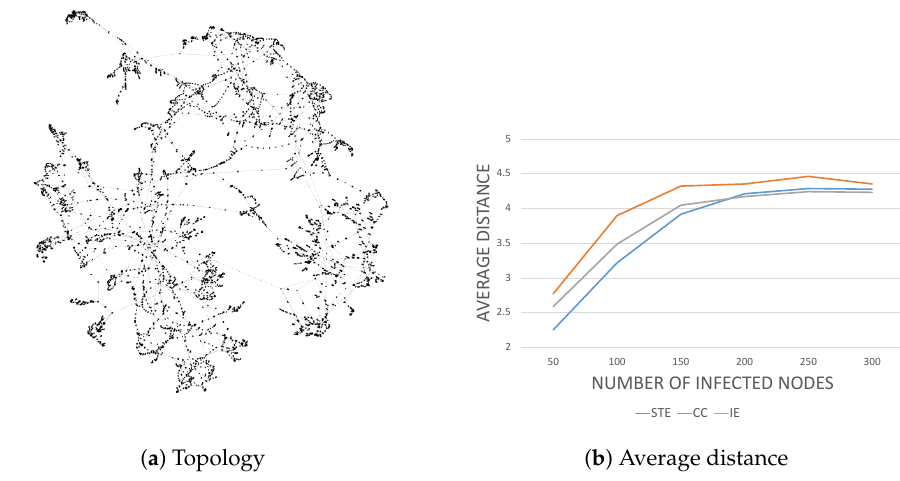
Figure 8. Detection performance in the power grid